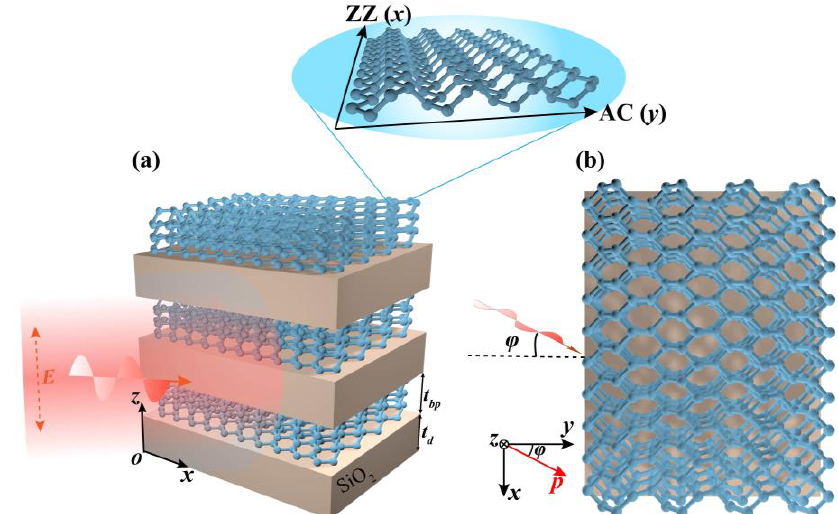
Figure 1. ( a ) Schematic of the proposed BP-based HMMs structure consisting of alternating BP / SiO 2 multilayer. The thickness of the SiO 2 and BP layer are t d and t bp , respectively. The thickness of periodic unit of the BP-based HMMs structure is d ( = t d + t bp ). ( b ) The top view of (a). A p -polarized light in p - z plane is incident on the side of the proposed BP-based HMMs structure from air. ϕ is the angle between the incident p - z plane and y - z plane.